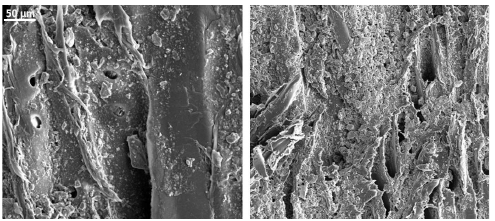
Figure A6. SEM image of wood surface for non-ESD ( left ) and ESD ( right ) scaled to 50 µm.